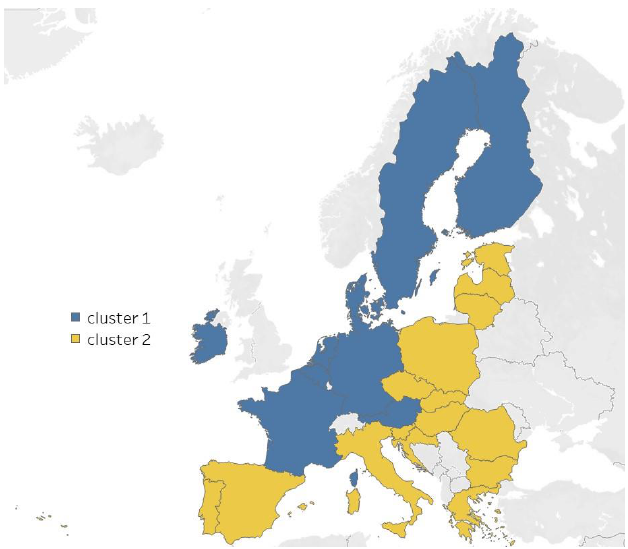
Figure 4. Choropleth map for the “ macroeconomic heterogeneity ” . Source: Authors ’ study based on [75]. Table 9. “ Macroeconomic heterogeneity ”— values of diagnostic variables for the countries consti- tuting cluster 1.